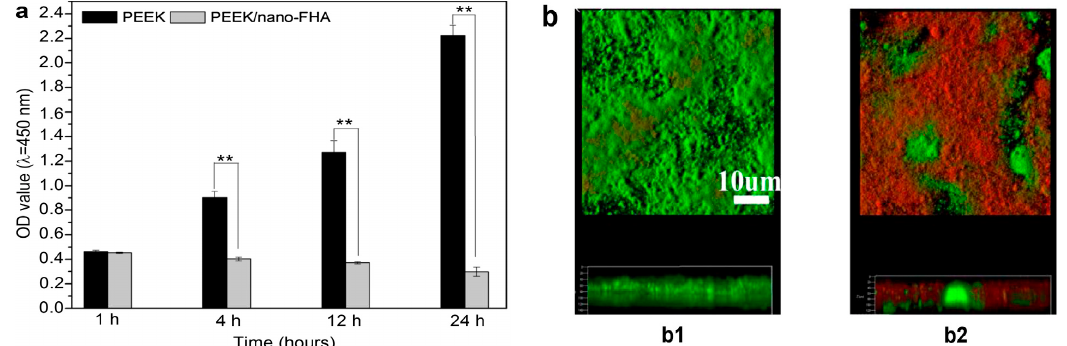
Figure 20. ( a ) Bactericidal activities of PEEK and PEEK/nano-FHA composite samples against S. mutans cultured for different time points. ( b ) Live/dead cell staining of S. mutans cultured on PEEK ( b1 ) and PEEK/nano-FHA ( b2 ) for 14 days. ** represents p < 0.01. Reproduced from [164] with permission of Elsevier.